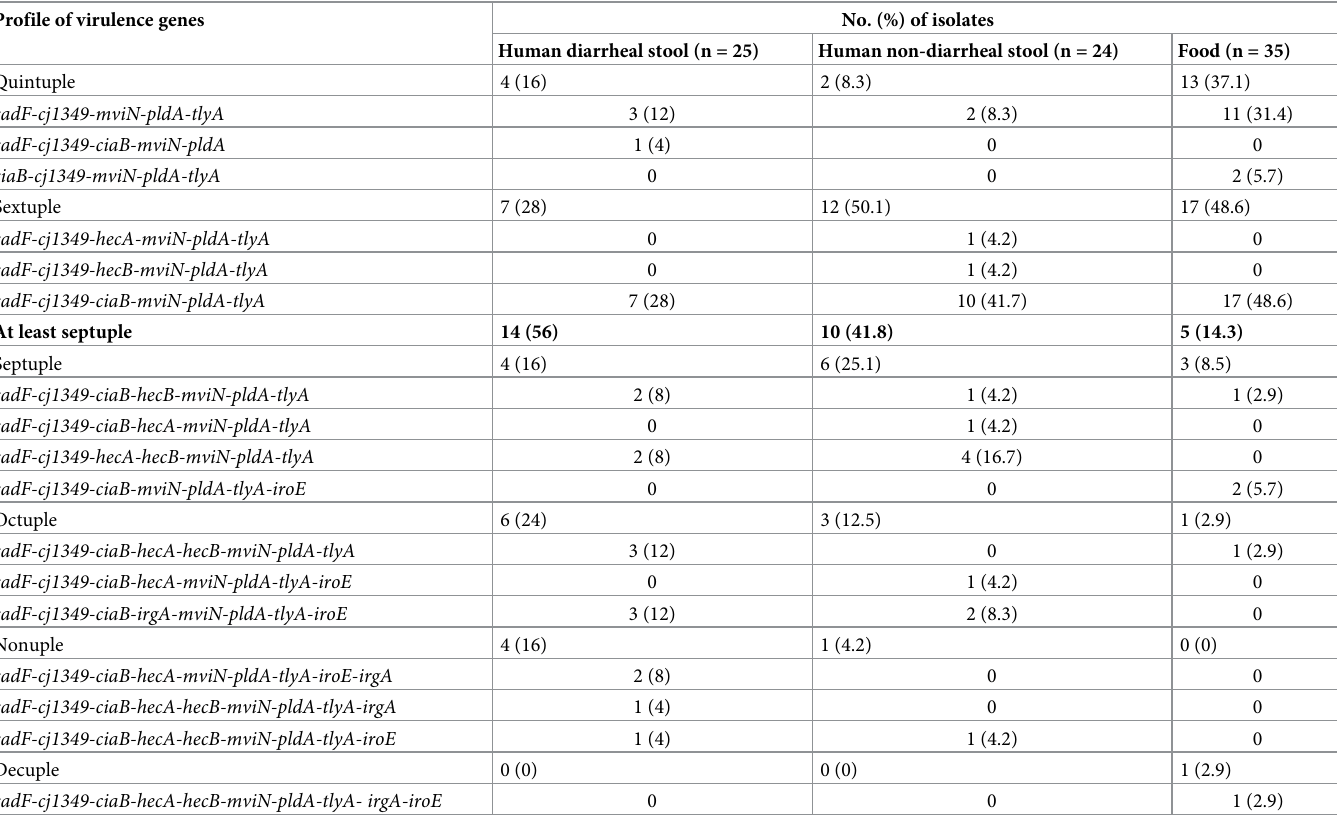
Table 3. The profiles of putative virulence genes of Arcobacter butzleri isolates from human diarrheal stool and non-diarrheal stool and food samples. Profile of virulence